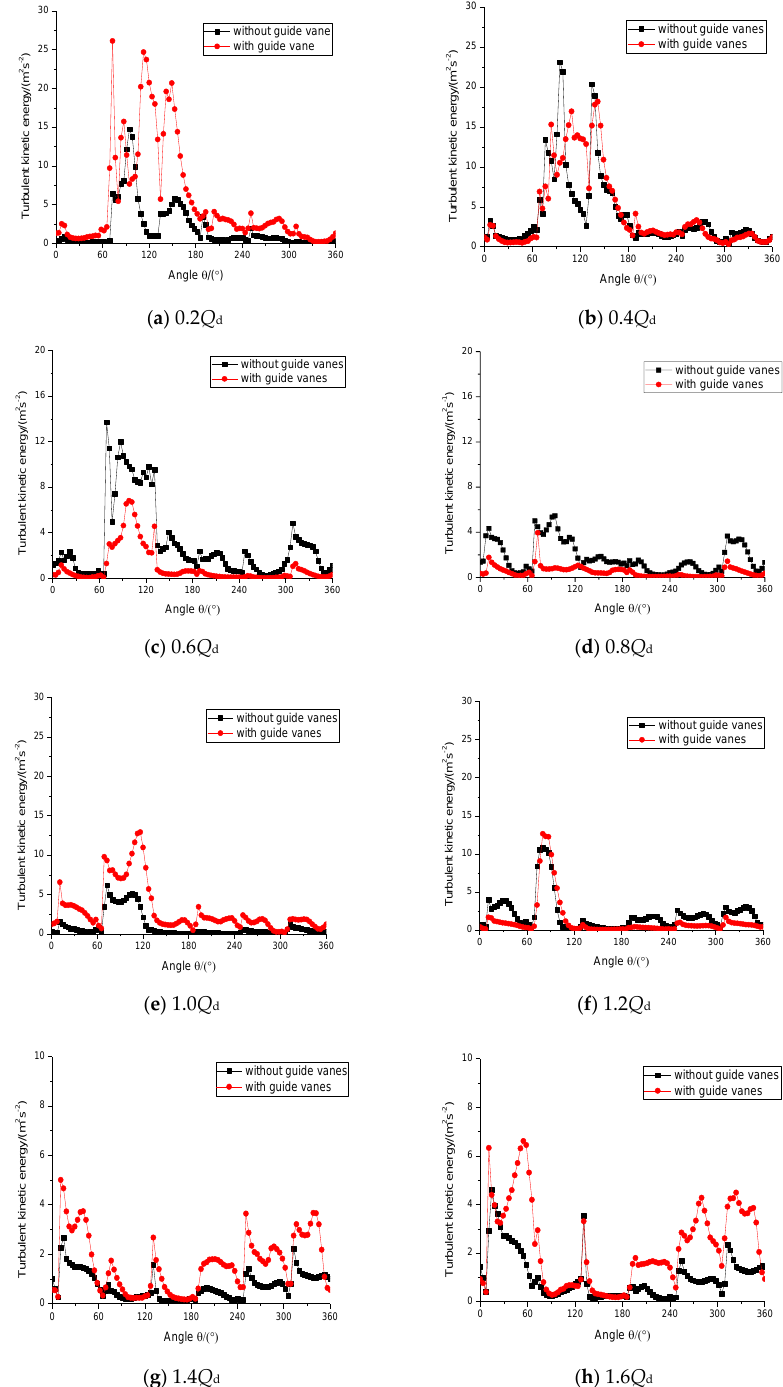
Figure 9. Turbulent kinetic energy distribution in the impeller.